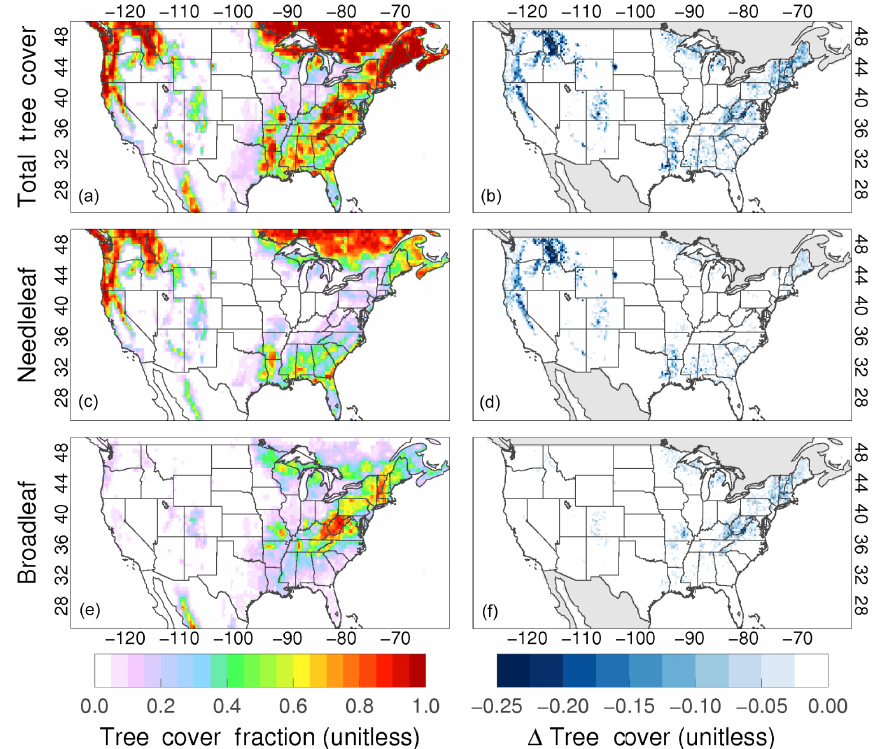
Figure 2. Fraction of grid box covered by trees in present day (left), and the loss in tree cover due to predicted mortality from 2013 to 2027 based on the National Insect and Disease Risk Map (right). (a, b) Total tree cover; (c, d) needleleaf tree cover only; (e, f) broadleaf tree cover only. Table 1. Descriptions of the individual simulations used here to test the impacts of large-scale tree mortality.